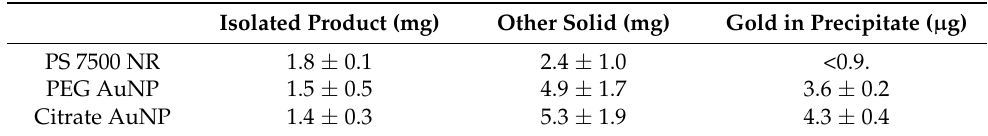
Table 2. Analysis of precipitate from cascade reaction ( n =